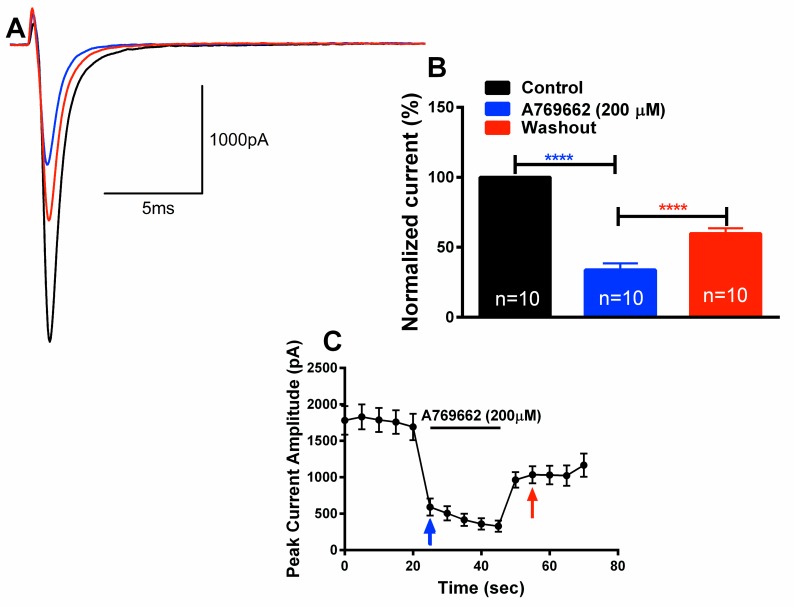
A769662 blocks hNav1.7 currents in HEK cells.(A) A step from -80 mV to 0 mV for 25 ms was used to elicit currents in hNav1.7-transfected HEK cells with or without A769662 application. (B) Acute application of A769662 (200 μM) reduced the Na+ current amplitude in hNav1.7-transfected HEK cells (n = 10, one-way ANOVA, **** p < 0.0001 C) Peak current vs time plot of the effect of A769662 on hNav1.7 currents. Arrows correspond to A769662 (blue) and washout (red) in A) and B).